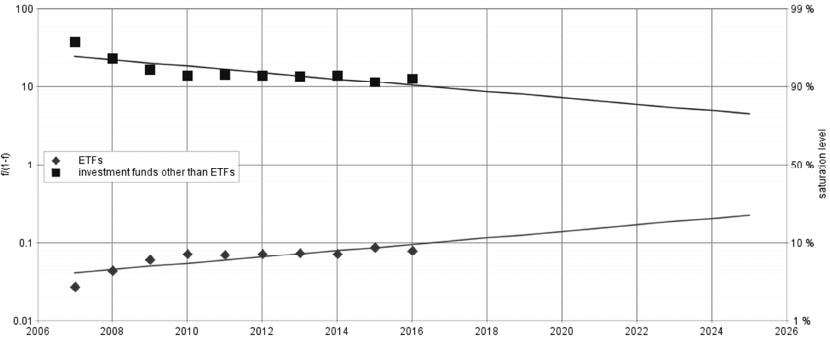
Figure 7. Investment funds observed and predicted substitution patterns in Germany.